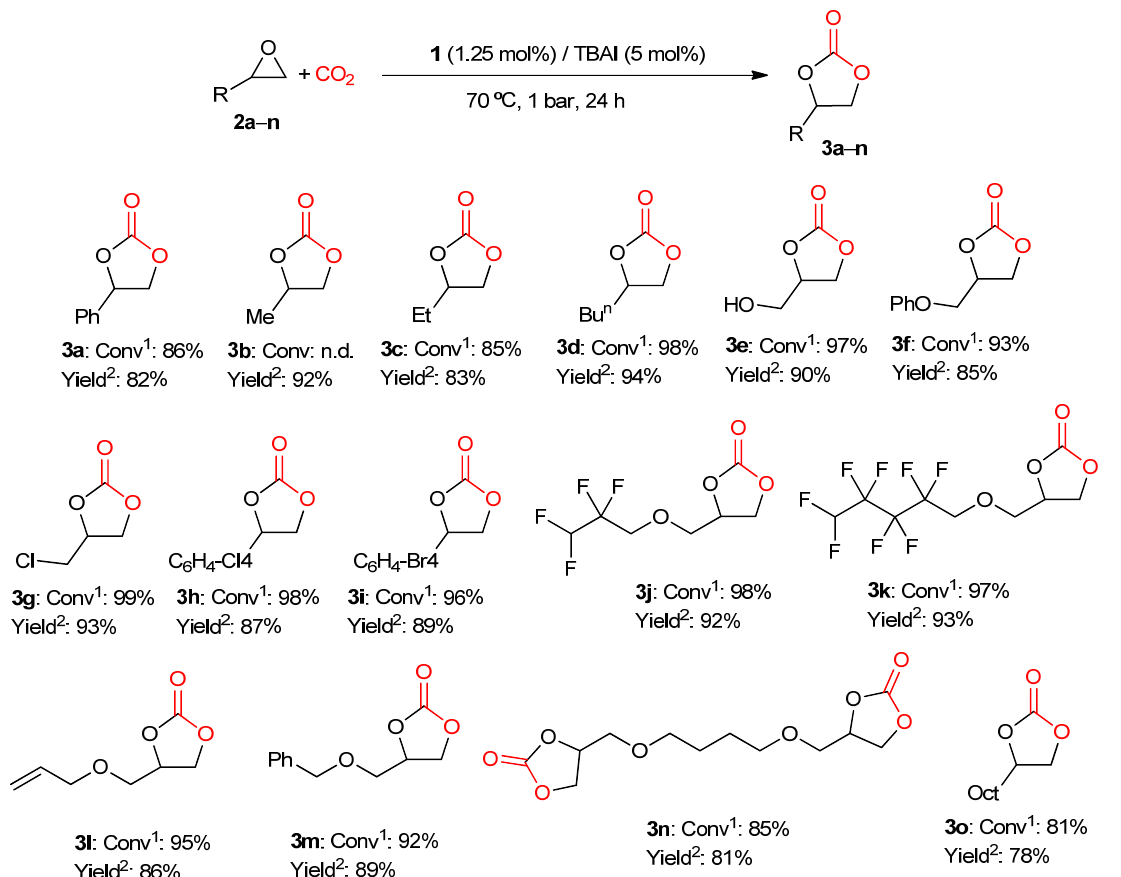
Figure 5. Cyclic carbonates 3a–o were synthesized by 1 /TBAI in a 1:4 molar ratio. Reactions were carried out at 70 °C and 1.0 bar CO 2 pressure under solvent-free conditions. 1 Conversions were established by 1 H NMR spectroscopy of the crude reaction mixture. 2 Isolated yields were achieved from purified cyclic carbonate.